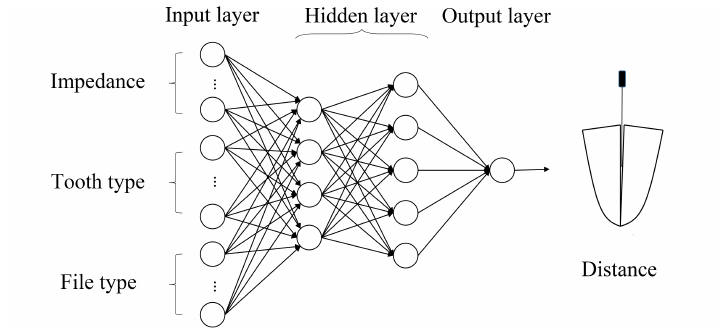
Figure 6. Schematic of neural network